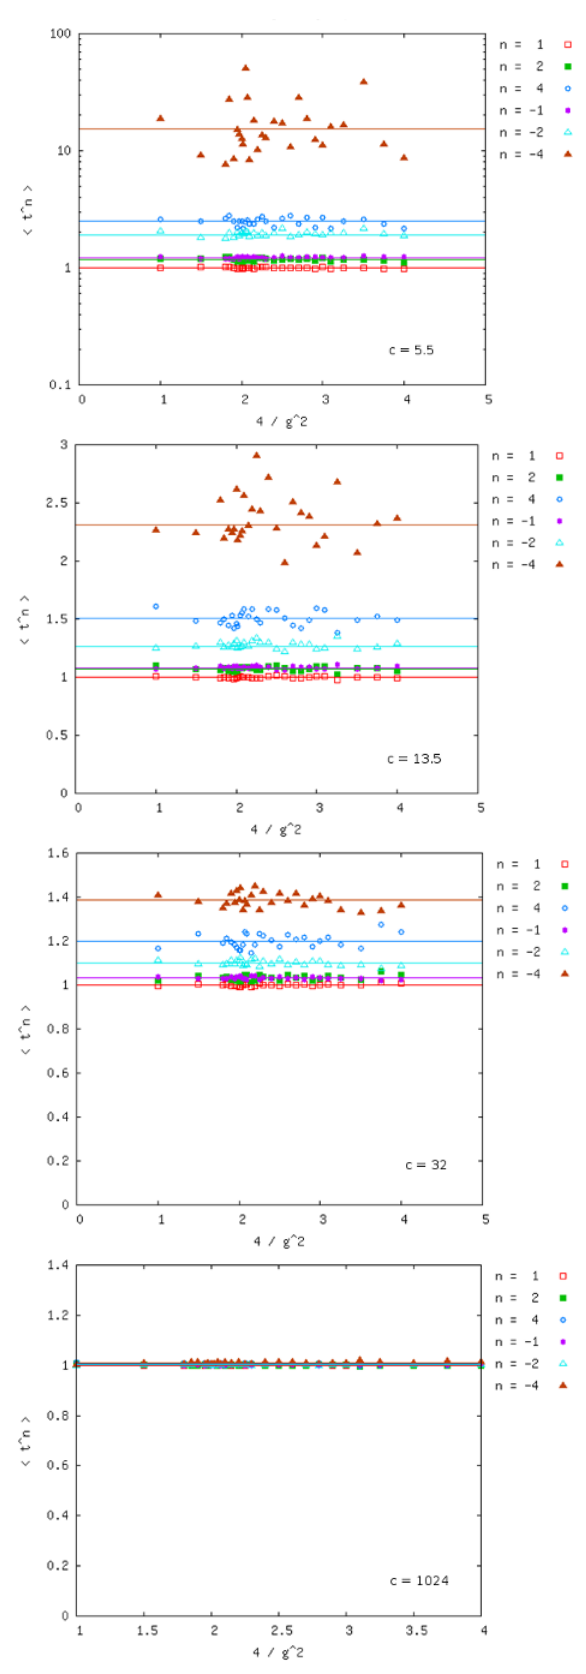
Fig. 6. The average values of the di ff erent powers of the asym- metry parameter at di ff erent couplings in our Monte-Carlo simu- lations for the Tsallis parameters c = 5 . 5 , 13 . 5 , 32 . 0 , and 1024 . 0.